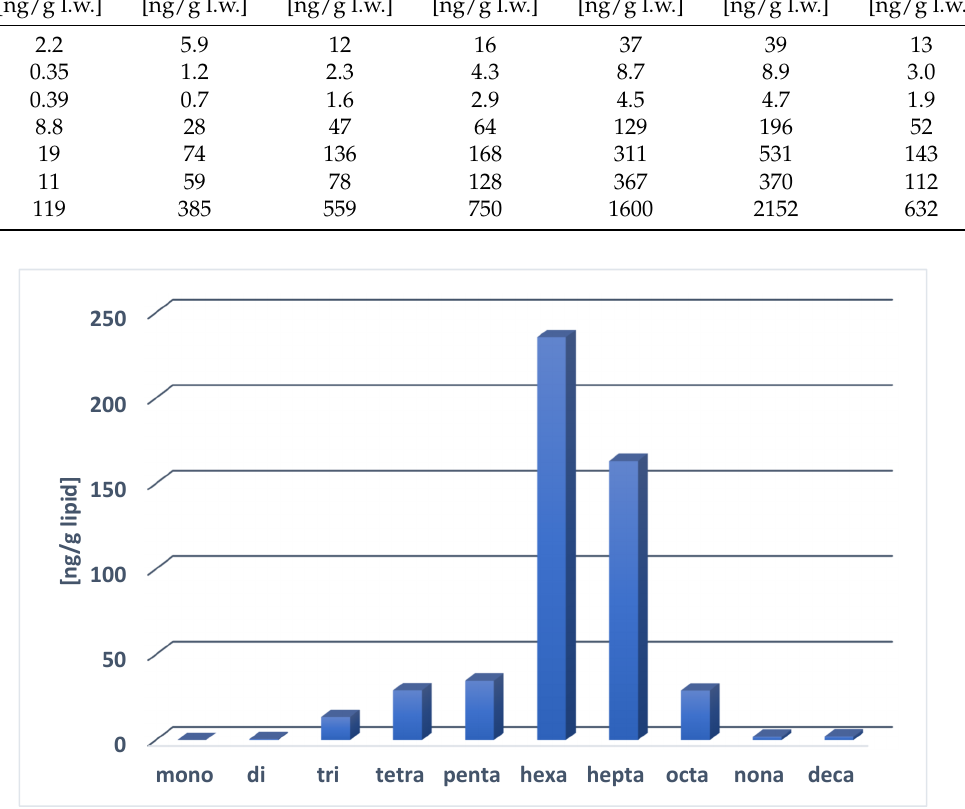
Figure 1. Median levels of PCB homolog groups (ng/g l.w.) in whole blood samples of the study group ( n = 35).